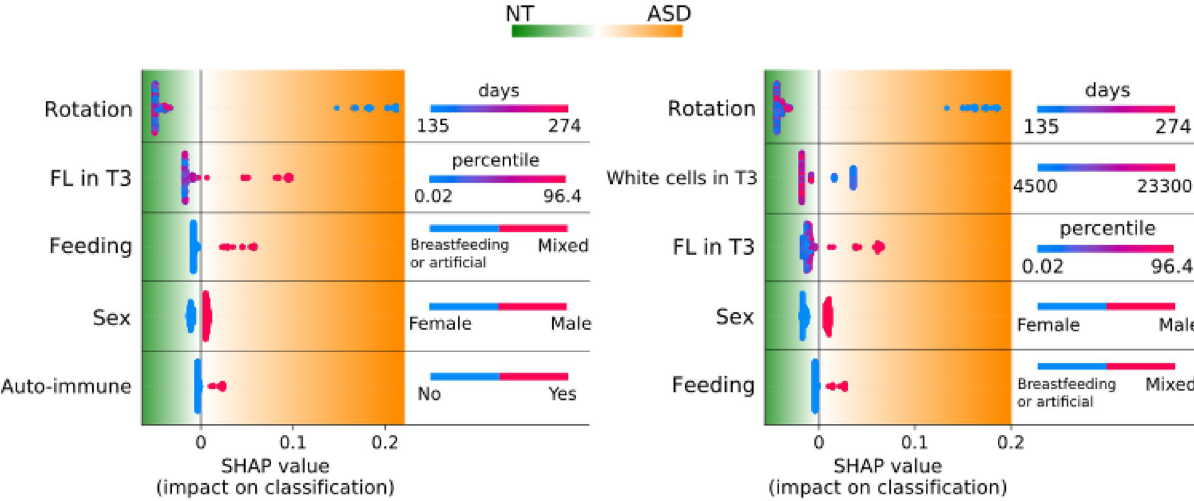
Figure 2. Features with the highest impact on the classifier based on SHAP analysis. Left: classification with the semi-automatic FSS. Right: classification with the automatic FSS. The impact (SHAP values) of the features on the classification as NT or ASD is shown. The features are ordered from top to bottom according to their decreasing impact. Each point at each feature line represents a baby colored by the corresponding feature value. In each plot, the feature values that lead the classifier to an NT or ASD prognosis are on the green and orange regions, respectively. T3, third trimester; Rotation, timing of fetal rotation on head; Feeding, newborn feeding; FL, femur length percentile; Auto-immune, familial maternal history of auto-immune diseases.